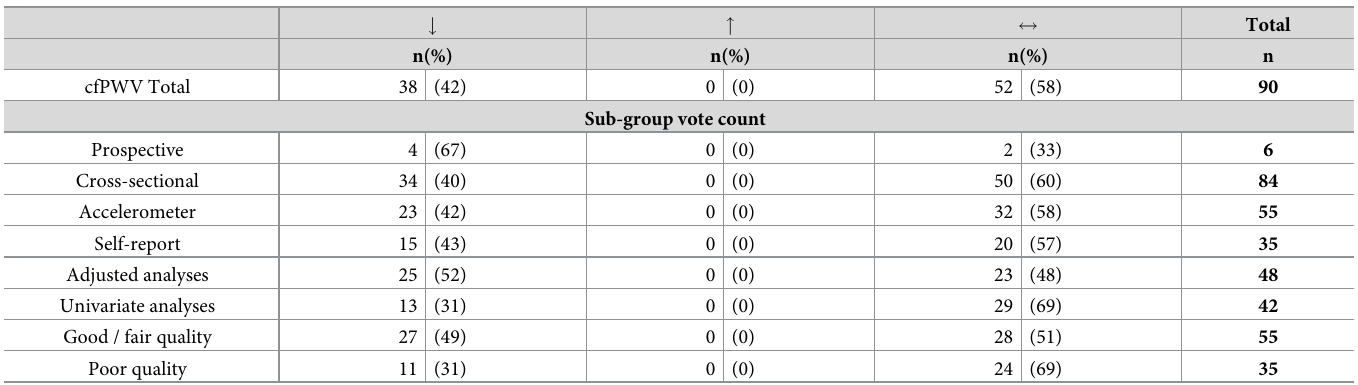
Table 2. Vote counting across all included